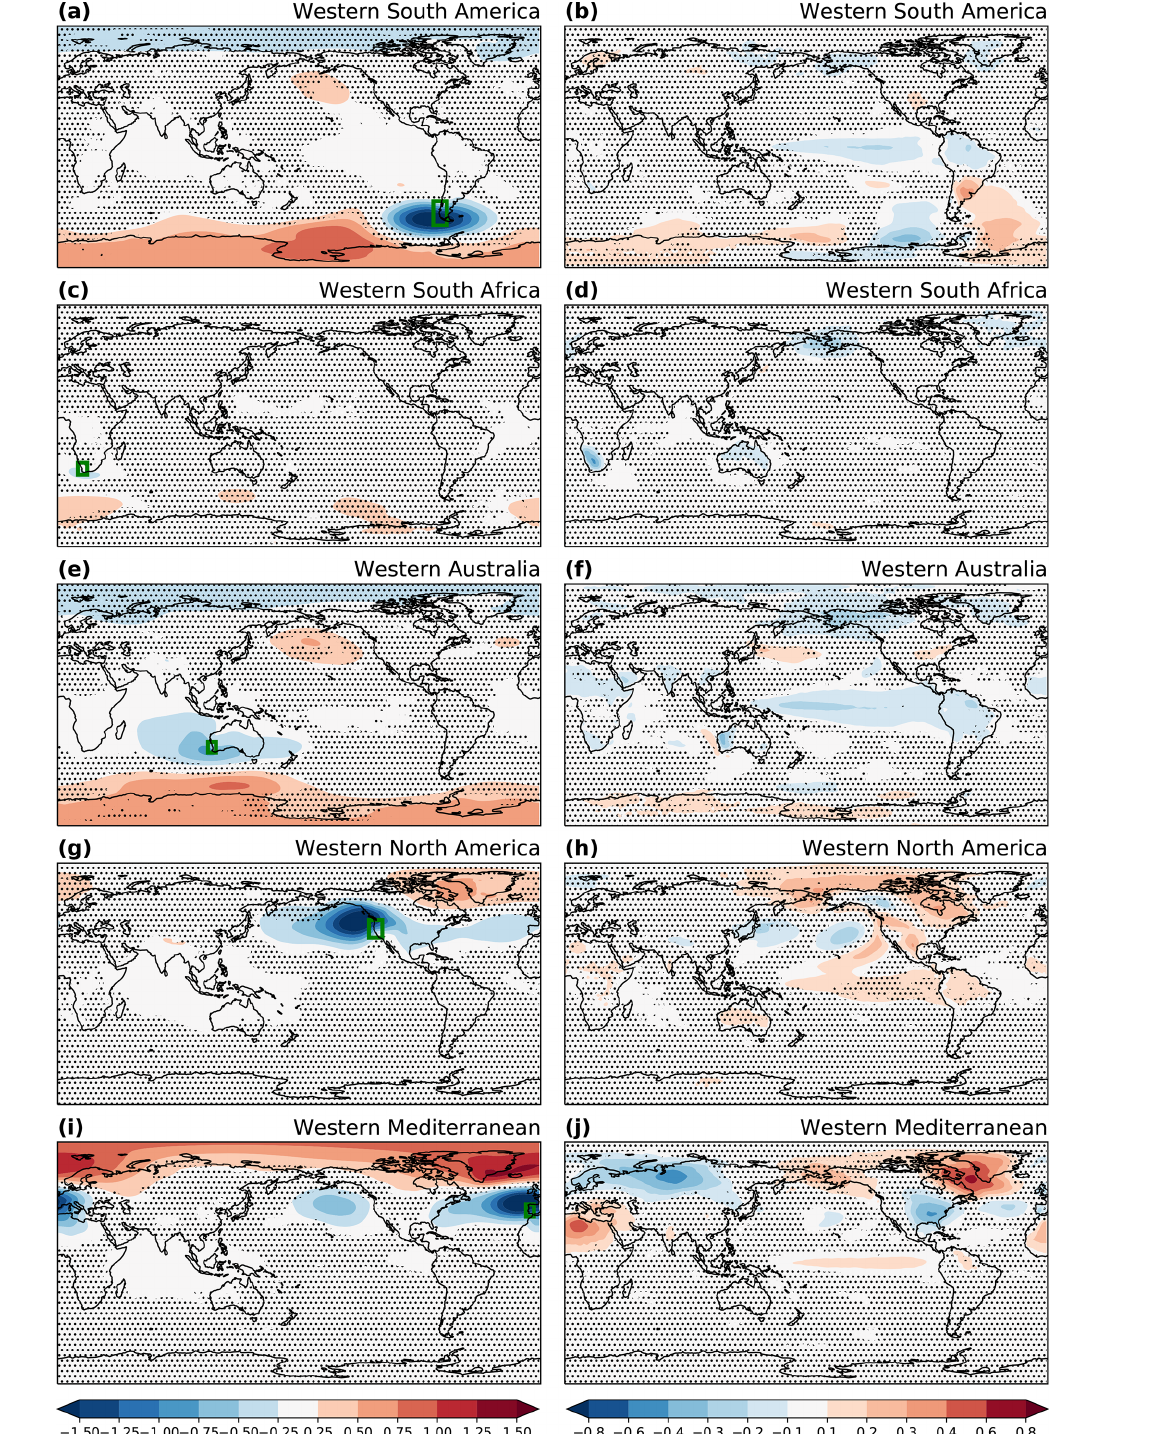
Figure 5. Sea level pressure (hPa) and surface air temperature ( ◦ C) anomaly composites for high precipitation years in five regions with Mediterranean climates (indicated by green boxes in the left-hand panels). Sea level pressure anomaly composites (a, c, e, g, i) and surface air temperature anomaly composites (b, d, f, h, j) show the large-scale patterns across models and experiments composited over years of anomalously high precipitation (defined as 1 standard deviation above the average) in each region. Stippling shows areas where fewer than two-thirds of the simulations agree on the sign of the pattern. Figures S2 and S3 show the corresponding composites for anomalously low precipitation and composites for the precipitation change in these